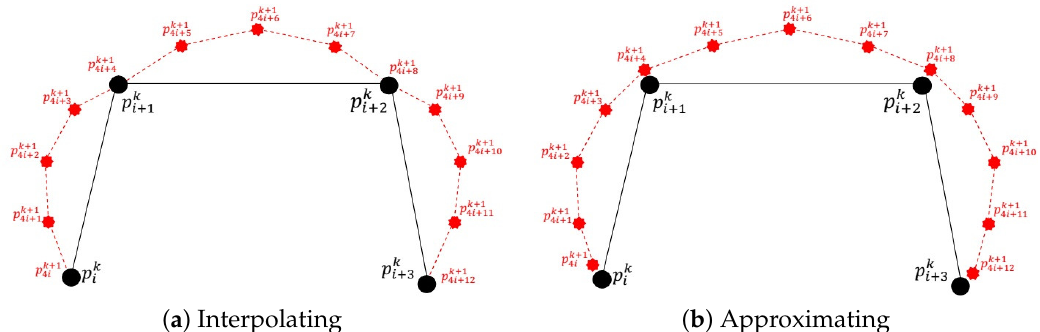
Figure 1. The configuration of new points for the interpolating and approximating QSS for curves; the solid lines are the control polygon, and the dotted lines are the refined